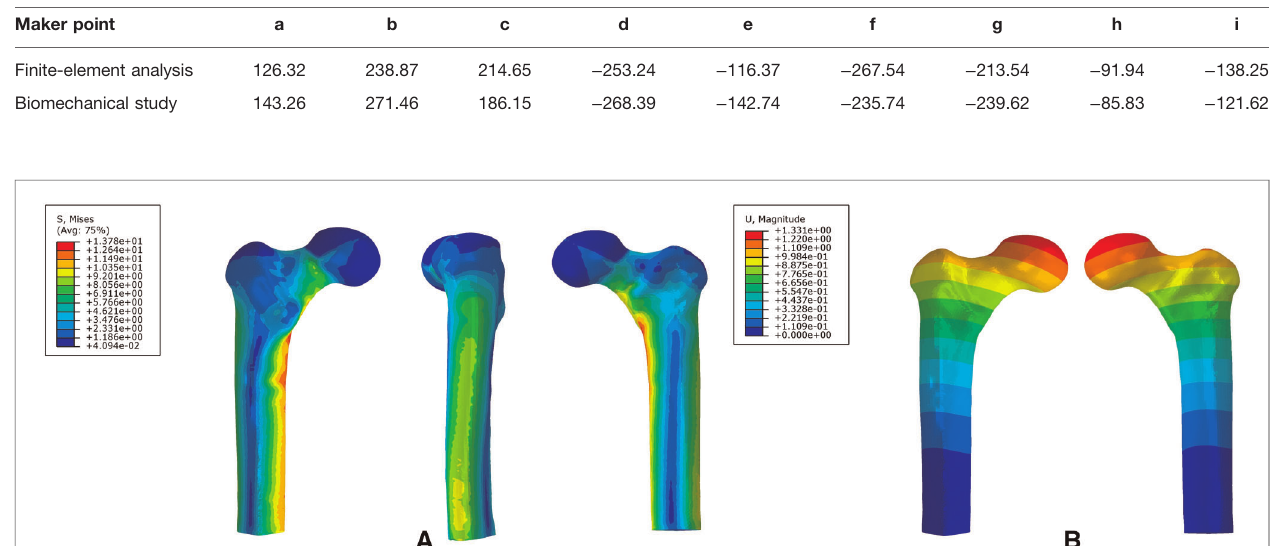
FIGURE 7 | The stress distribution ( A ) and displacement distribution ( B ) of an intact proximal